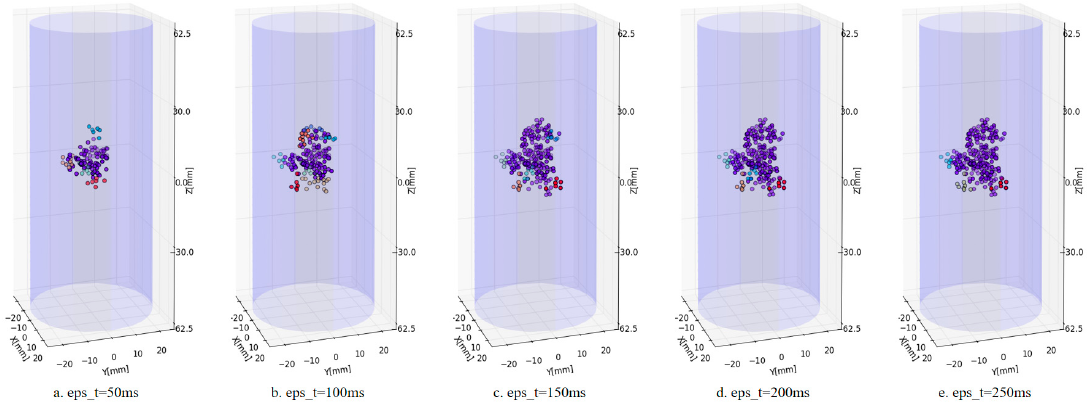
Figure 16. Calculated clusters using different Eps_t values and fixed Eps_s (5 mm), MinPts (7).